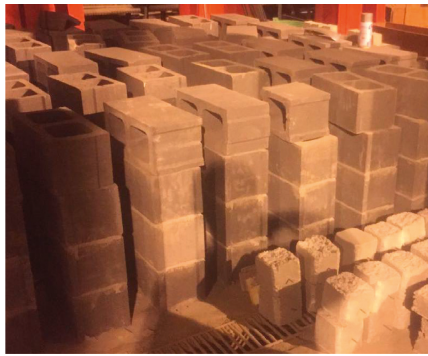
Figure 5: Photo of the